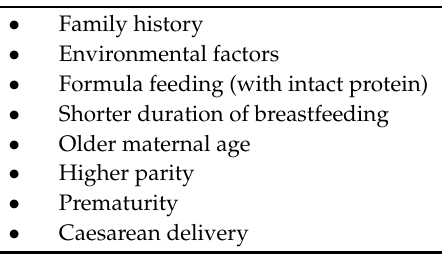
Table 1. Risk factors for allergy